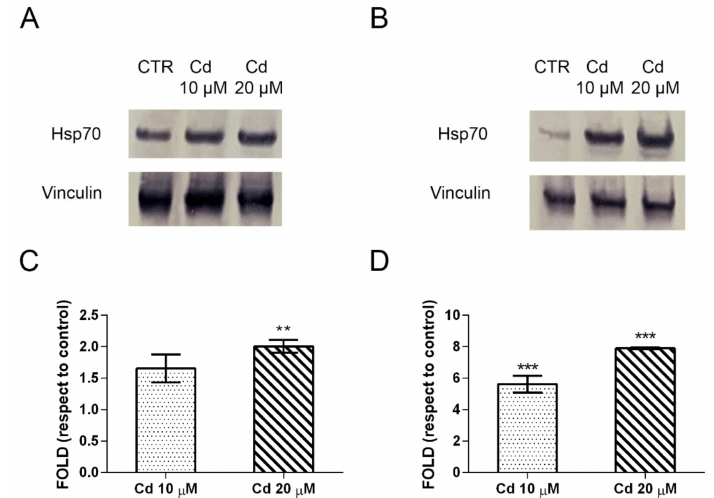
Figure 6. Heat shock protein 70 expression in cadmium-treated A549 and SH-SY5Y cells. Repre- sentative Western blots on A549 ( A ) and SH-SY5Y ( B ) samples exposed to 10 µ M and 20 µ M Cd for 24 h. Densitometric analyses performed with Scion Image Software are in the panels ( C ) (A549 cells) and ( D ) (SH-SY5Y cells). Values are presented as means ± standard error (SE) of three different experiments. Significantly different from control: ** p < 0.01; *** p < 0.001 (Dunnett’s test).